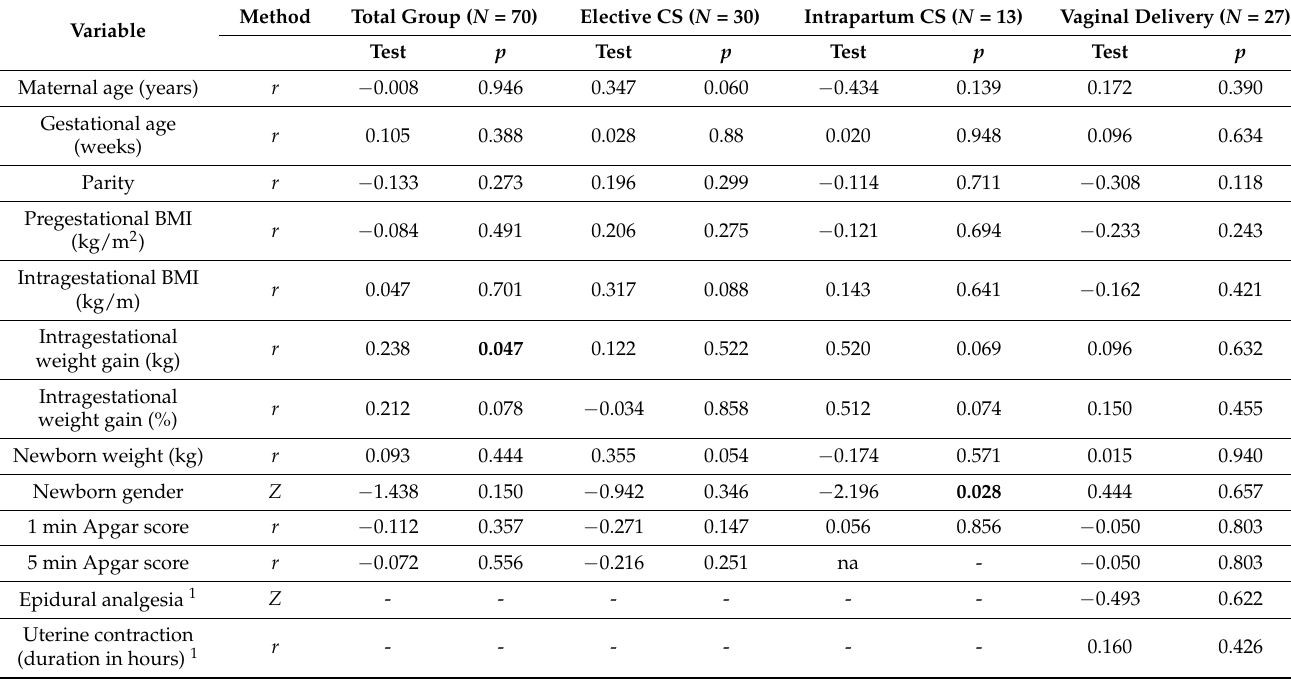
Table 2. Correlations between 5-mC/5-hmC ratio in the placenta and maternal or offspring